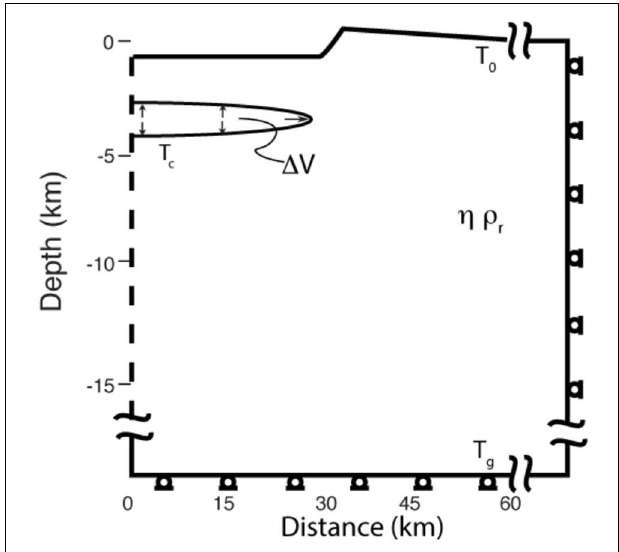
FIGURE 7 | Model setup illustration for a 1km-deep post-collapse caldera with a radius of 30km a circular approximation of the area of Toba Caldera. The left boundary condition is axial symmetry, the top of the model is free to deform, as is the magma reservoir boundary, and zero displacement, roller conditions are implemented along the right and bottom boundaries. The temperature of the magma reservoir ( T c ) is defined along the magma reservoir boundary, T 0 = 0 ◦ C is defined at the surface of the model, and an initial background geotherm ( T g = 30 ◦ C/km) is assumed. The temperature-dependent rheology assumes steady state thermal structure as an end-member for full thermal impact of a long-lived magma reservoir. Because steady-state temperature-dependence is an end-member situation, it is compared to the alternate end-member of a non temperature-dependent isoviscous model. Model setup includes caldera resurgence topography due to detumescence as well as recharge into a shallow magma reservoir. 1 V of magma intrusion into the magma reservoir is approximated by a pressurized void.